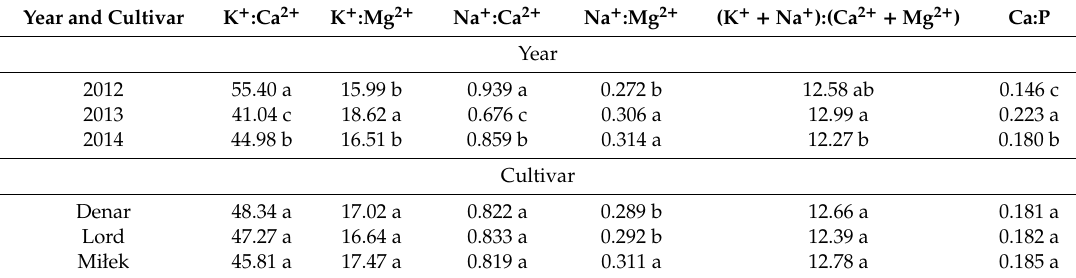
Table 6. Macronutrient ionic ratios in potato tubers in relation to potato growing season and cultivar. Year and